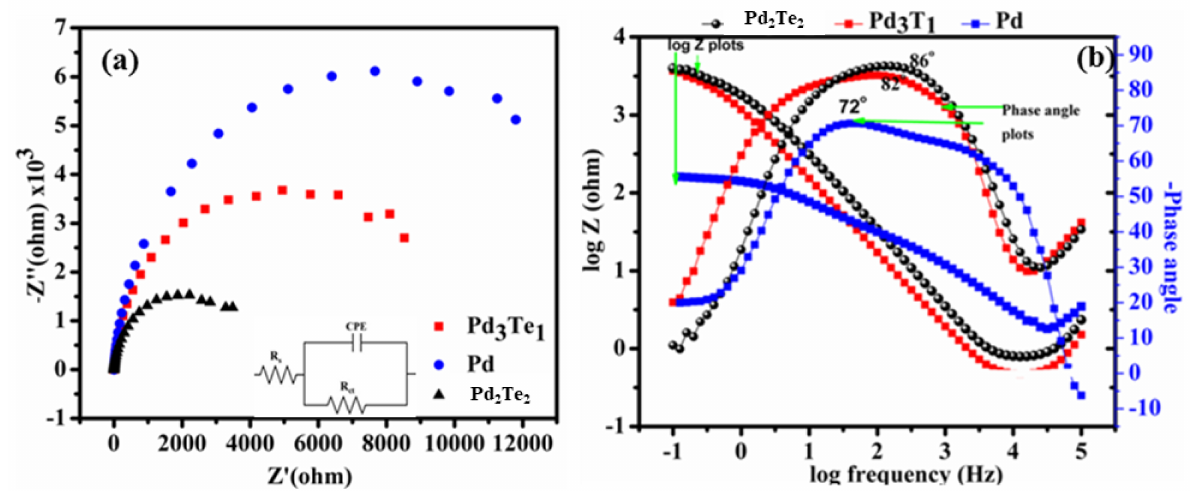
Figure 6. Nyquist plots generated for electrode catalysts in a solution of EtOH at − 0.2 V and 1 × 10 4 –0.1 Hz. The insert presents the equivalent circuit used to fit the impedance